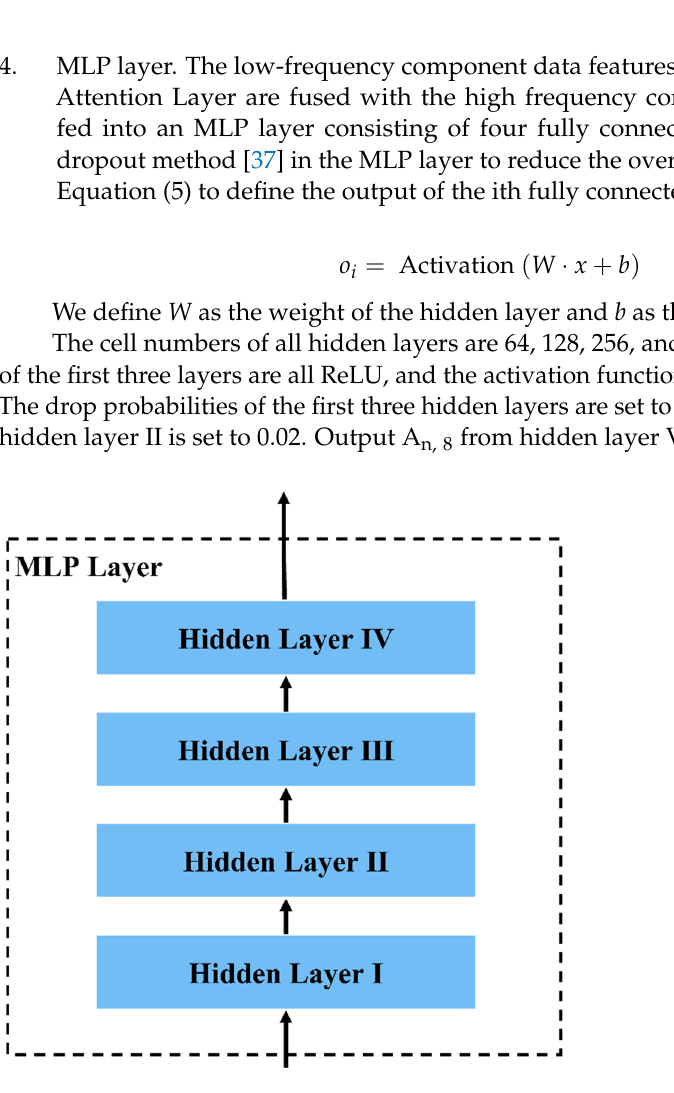
Figure 5. Structure of the Transformer Encoder in the attention block.